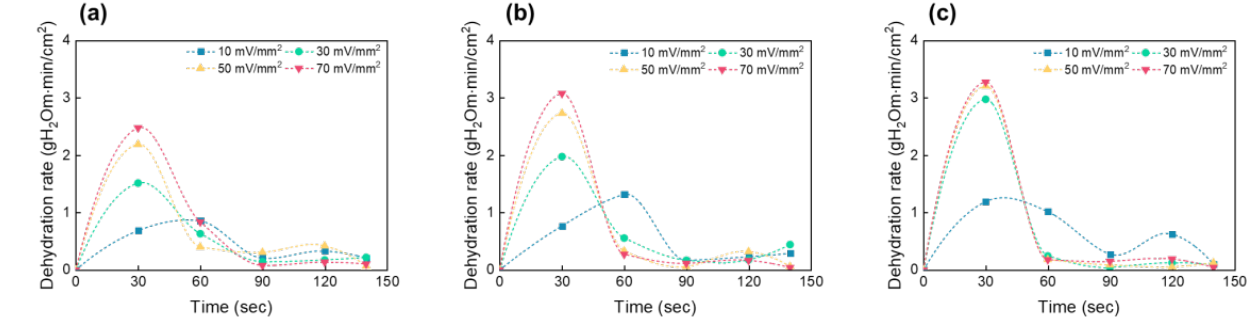
Figure 3. Dehydration rates of sewage sludge cakes with various voltages with respect to processing times of ( a ) 2 mm, ( b ) 1 mm, and ( c ) 0.5